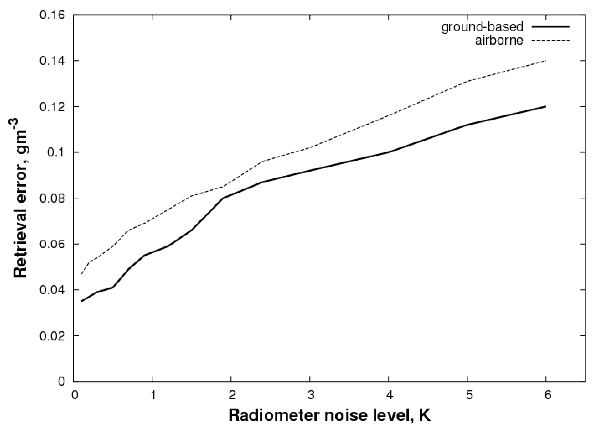
Figure 8. The retrieval error increases with the uncertainty in the estimate of background brightness temperature for both the ground-based and airborne setups. The stratocumulus Fig. 8. The retrieval error increases with the uncertainty in the es- cloud case is used for this sensitivity test. timate of background brightness temperature for both the ground- based and airborne setups. The stratocumulus cloud case is used for this sensitivity